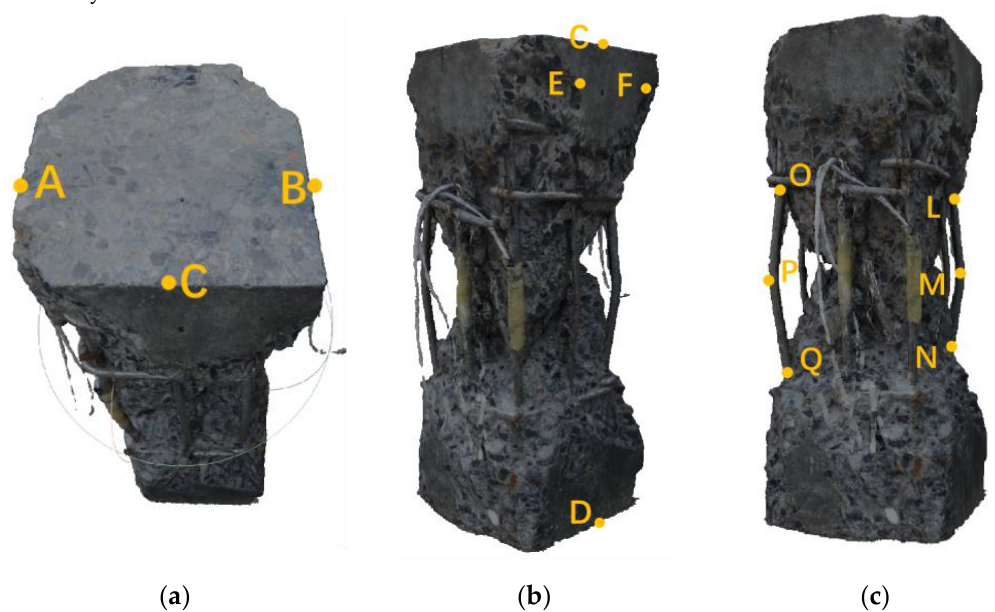
Figure 7. Location of calibration points on the square column. The purpose is to measure the distance of each calibration point as the criterion of accuracy. Table 2. The size conversion relationship between the 3D reconstruction model and the actual struc- ture.